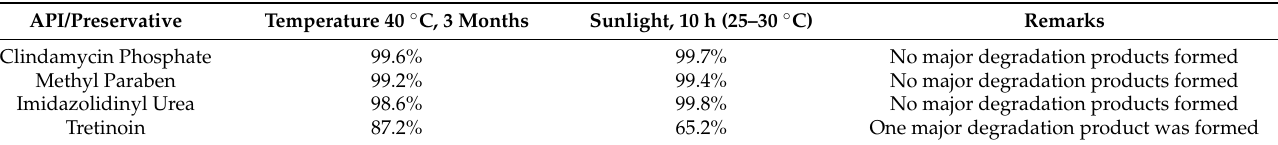
Table 5. Observed data for forced degradation study of the studied drugs.